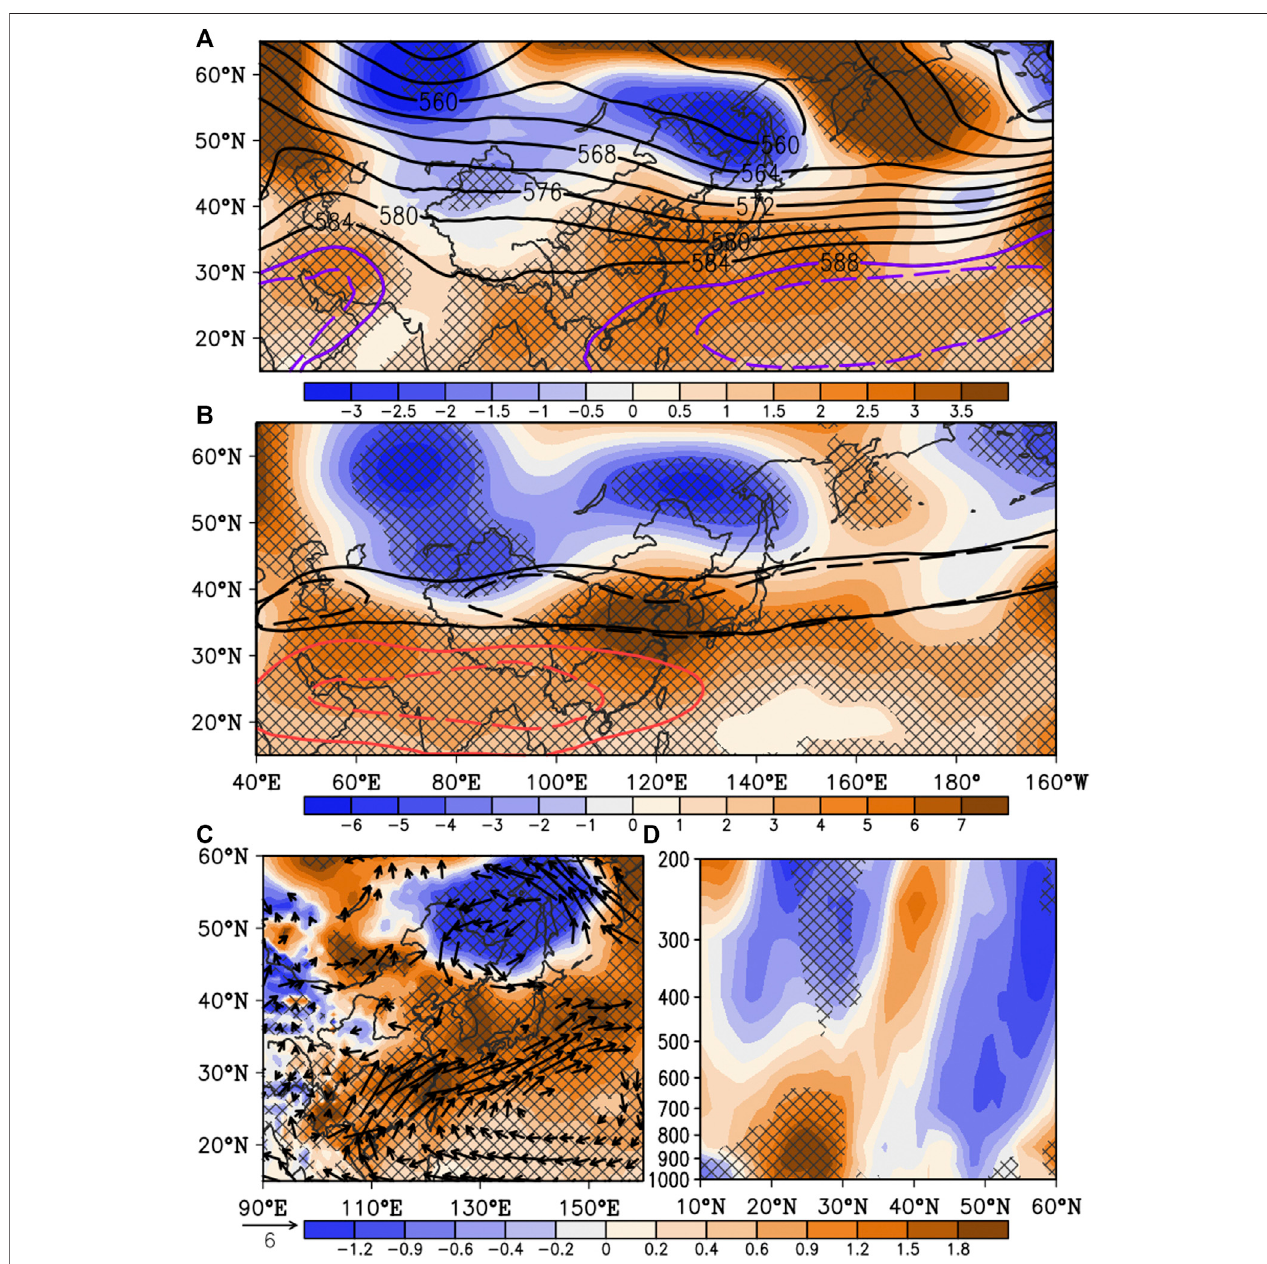
FIGURE3|(A) Compositesoforiginalvalues(contours,unit:dagpm)andanomalies(shaded, unit:dagpm)of500-hPa geopotentialheightsaveragedfromJune1 to June 30, 2020. Purple solid and dashed lines are 2020 and climatological 588-dagpm contour of 500-hPa geopotential heights, respectively. (B) Composite anomalies of 200-hPageopotential heights (shaded,unit: dagpm) averaged from June 1 toJune 30, 2020. Black solid and dash lines are 2020and climatological 30m s -1 contour of 200-hPa zonal winds, respectively. Red solid and dash lines are 2020 and climatological 1,252-dagpm contour of 200-hPa geopotential heights, respectively. (C) Composite anomalies of 925-hPa air temperature (shaded, unit: ° C) and winds (unit: m s -1 ). Only anomaly winds value exceeding 0.05 signi fi cance level is shown by vectors. (D) Vertical section of composite anomalies of meridional winds (unit: m s -1 ) averaged over East Asia along 105 o E – 135 o E. Crossed area in each panel denotes anomalies exceeding 0.05 signi fi cance